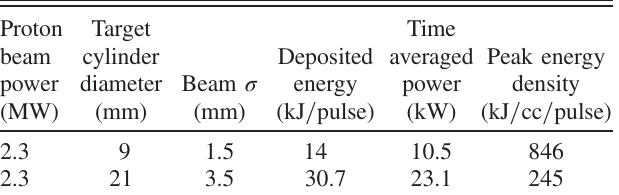
TABLE II. Results from Monte-Carlo FLUKA simulations showing range of energy deposition in a beryllium target.